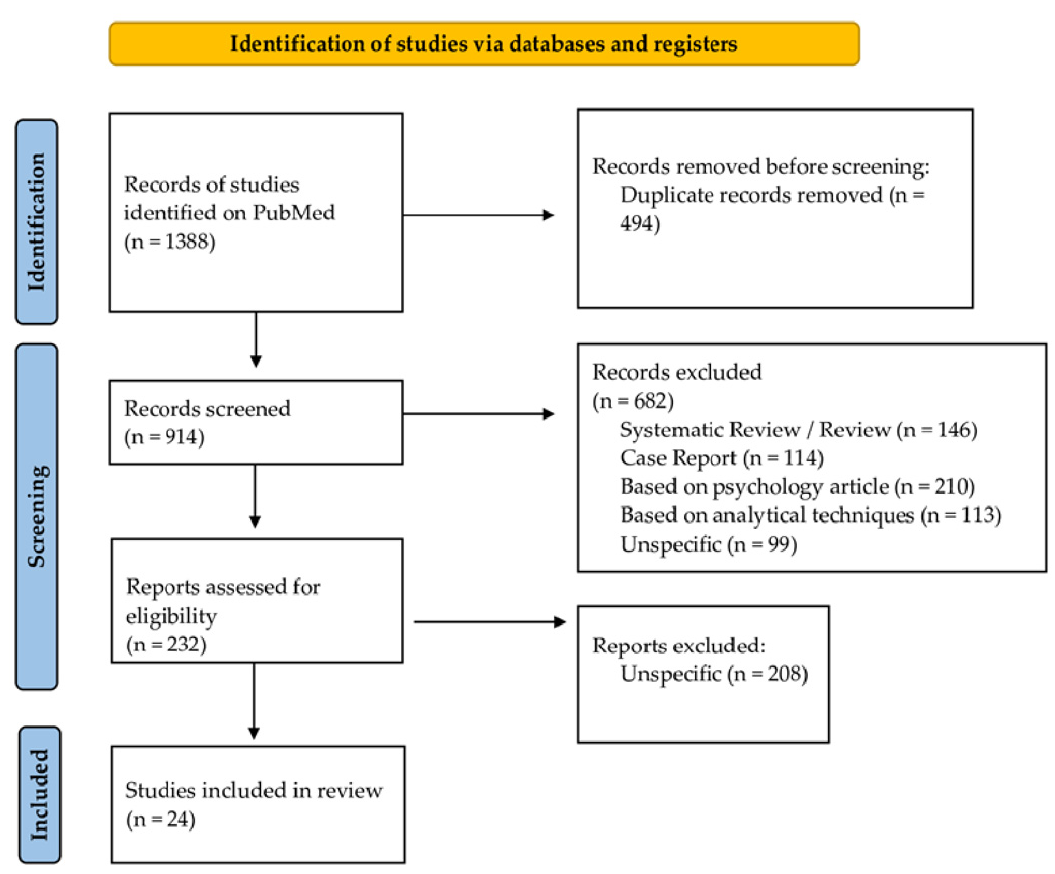
Figure 1. Flow diagram illustrating the search strategy and included and excluded studies in this systematic review.